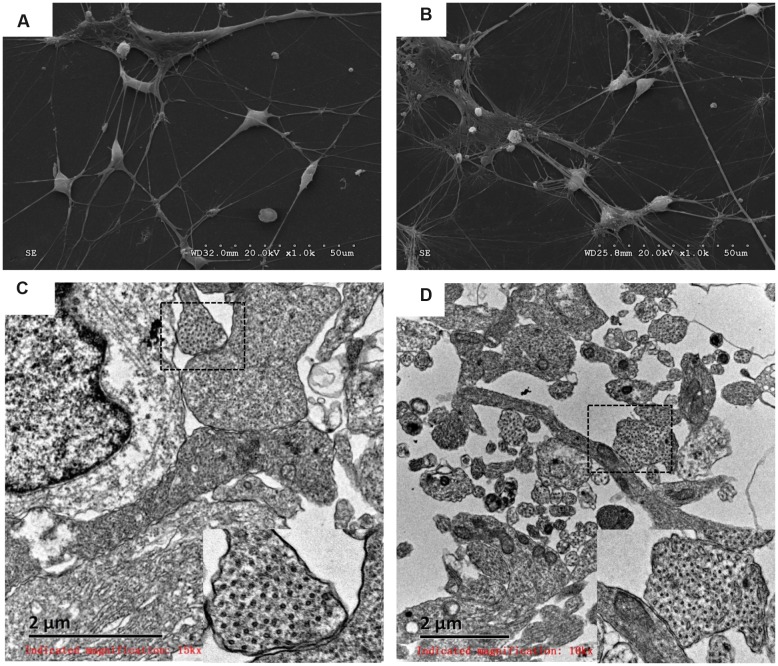
Analysis of P96- and HN4-derived DA neurons by scanning electron micrograph and transmission electron micrograph.
(A,B) P96- (A) and HN4-derived neurons (B) showed the elongated, angular A9 DA neurons with laterally and ventrally projecting dendrites. (C,D) The ultrastructure of P96- (C) and HN4-derived DA neurons (D) showed nucleus containing euchromatin, neurofilaments, and ribosomes. The typical synaptic structure and numerous synaptic vesicles located in presynaptic zone were observed in the dashed frame.